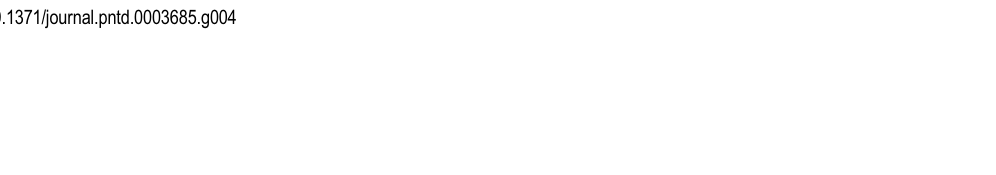
PLOS Neglected Tropical Diseases | DOI:10.1371/journal.pntd.0003685 April 1,